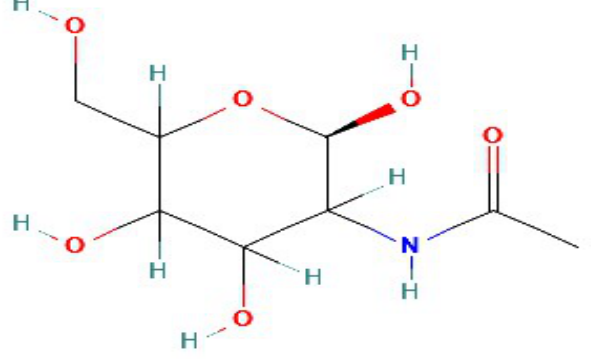
Figure 1. Chemical structure of the chitin; Source Pubchem (https://pubchem.ncbi.nlm.nih.gov/; (accessed on 10 September